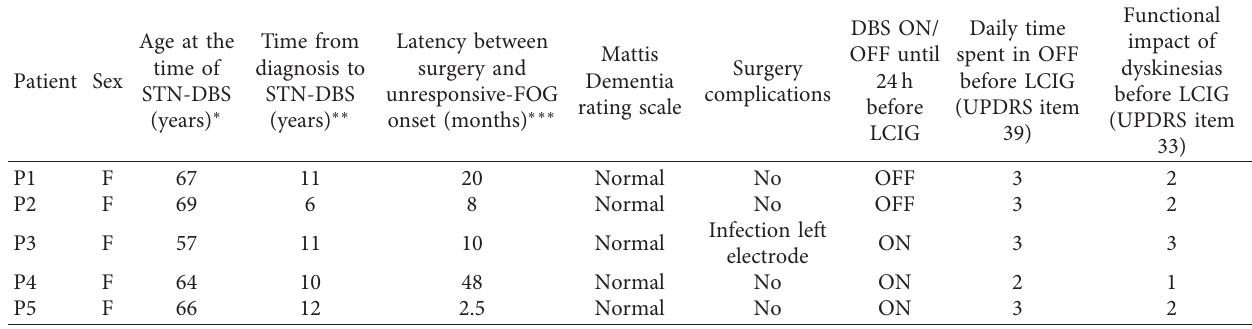
Table 1: Clinical, demographic, and surgical data.